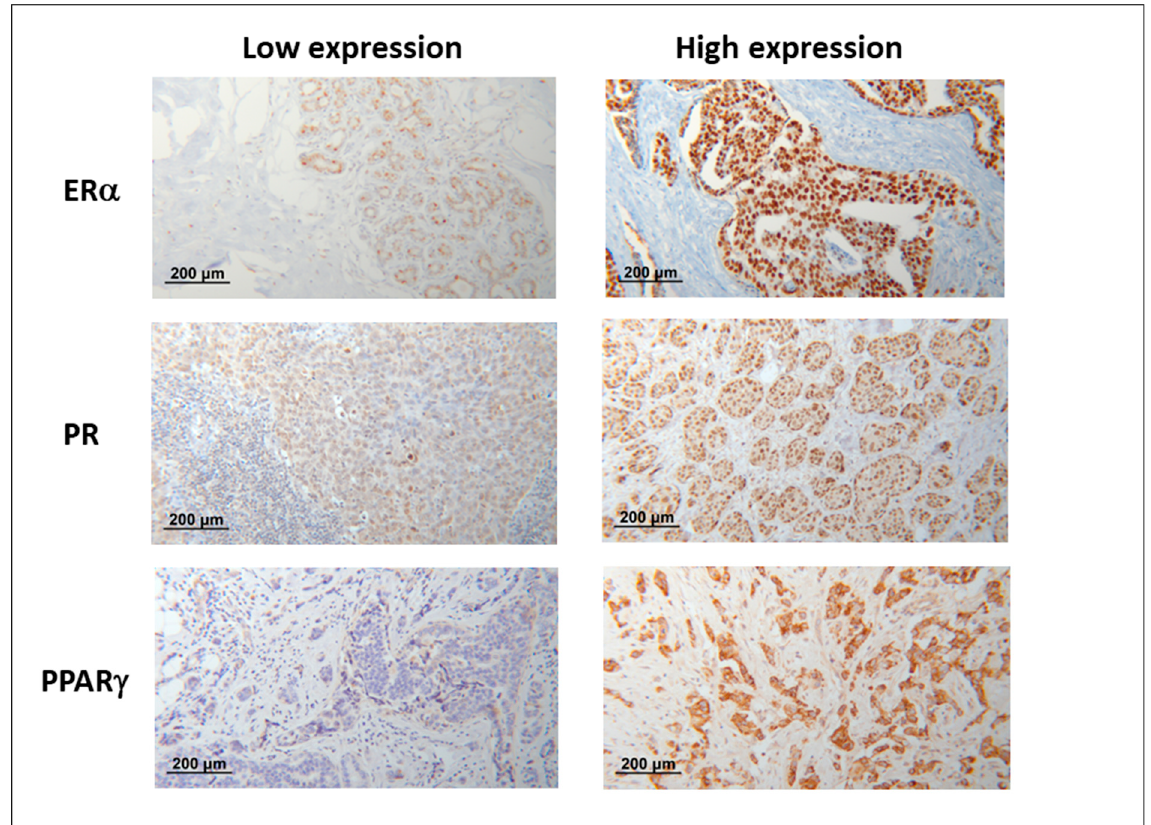
Figure 1. Representative microphotographs of low and high expression of ER α (estrogen receptor alpha), PR (progesterone receptor), and PPAR γ (peroxisome proliferator-activated receptor gamma) in 25 ×